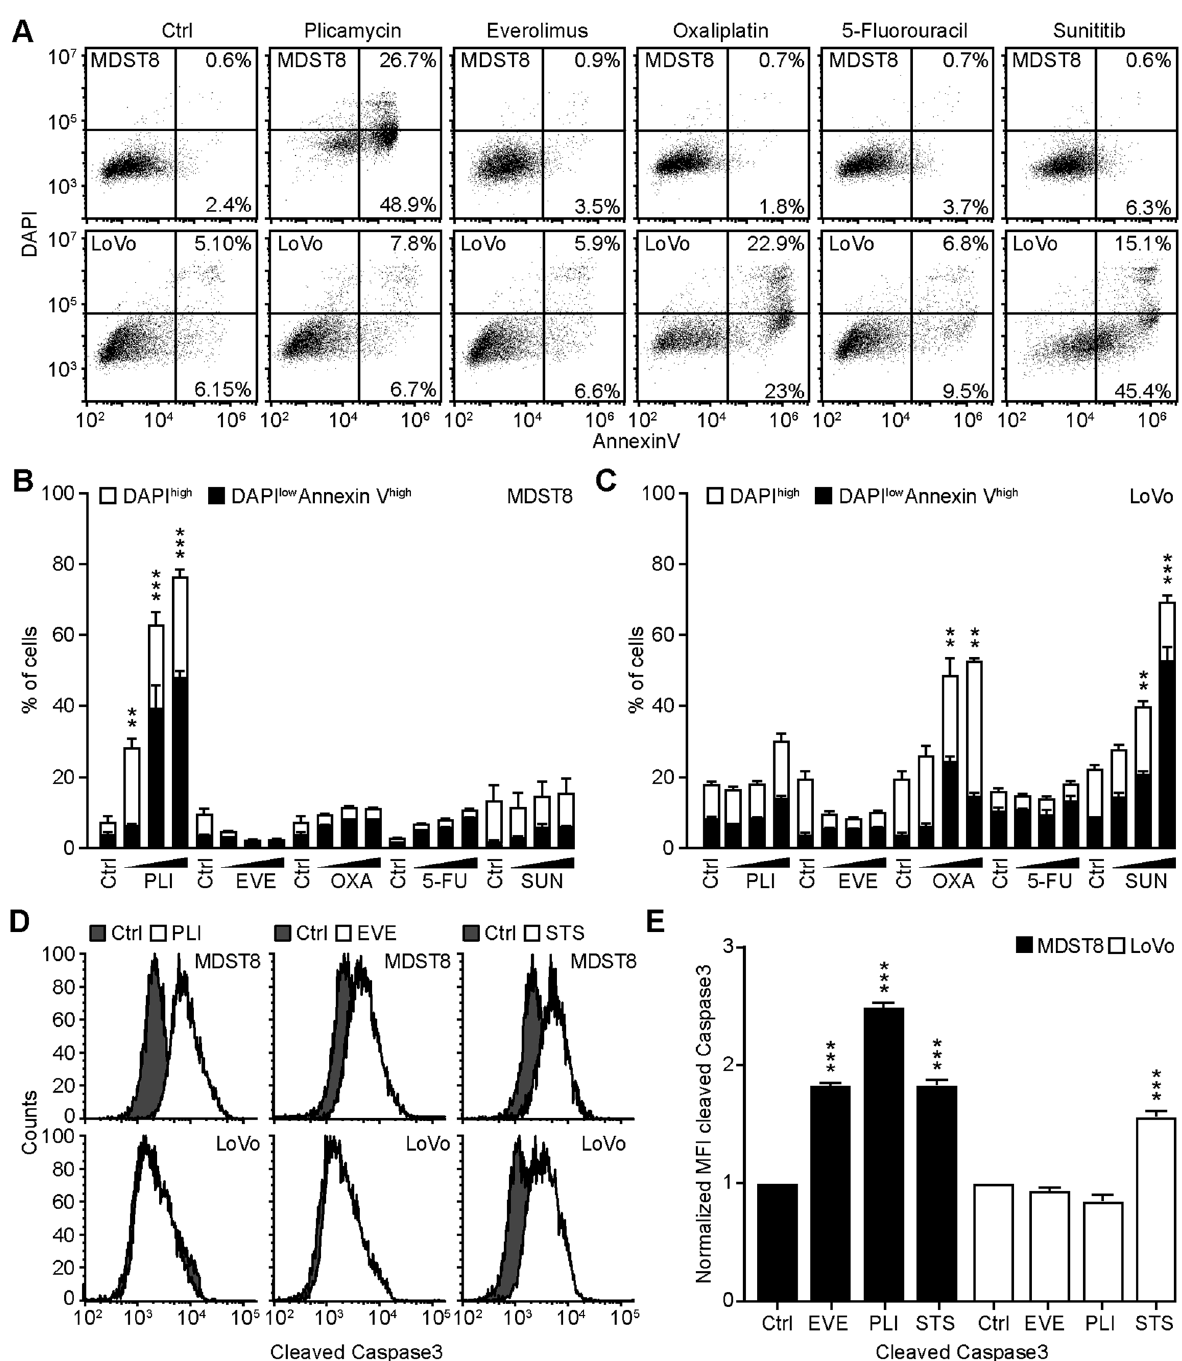
Fig. 2 Plicamycin induces cell death in MDST8. Wild-type (WT) MDST8 and LoVo cells were treated with plicamycin (PLI at 25, 50, and 100 nM for 72 h), everolimus (EVE at 10, 100 nM and 1 μ M for 72 h), oxaliplatin (OXA; 2.5, 5 and 10 μ M for 48 h), 5- fl uorouracil (5-FU; 2.5, 5 and 10 μ M for 48 h), sunitinib (SUN; 2.5, 5 and 10 μ M for 48 h). Then, cells were stained with the DAPI and Annexin V to measure apoptotic cell death ( A – C ). A Representative dot plots of untreated MDST8 and LoVo controls (Ctrl) or treated with plicamycin 100 nM, EVE 1 μ M, OXA 10 μ M, 5-FU 10 μ M, and SUN 10 μ M. Numbers indicate the percentage of cells in each quadrant. B , C The frequency of dying (DAPI low AnnexinV high ) and dead (DAPI high ) cells among the MDST8 ( B ) and LoVo ( C ) cells elicited by the corresponding drugs, as determined by analysis with the FlowJo software. Data are depicted as mean values of three independent experiments. D , E MDST8 cells were treated with 50 nM PLI, 0.1 μ M EVE or the positive control staurosporine (STS) 0.1 μ M for 48 h. Caspase-3 activation was measured by fl ow cytometric analysis upon staining with speci fi c antibodies. Representative histograms are shown in ( D ). Normalized mean fl uorescent intensity (MFI) of cleaved caspase-3 for each condition is depicted as bar chart ( E ). Error bars indicate SEM. Asterisks refer to signi fi cant effects for treatments versus control (paired Student ’ s t test; ** P < 0.01, *** P <